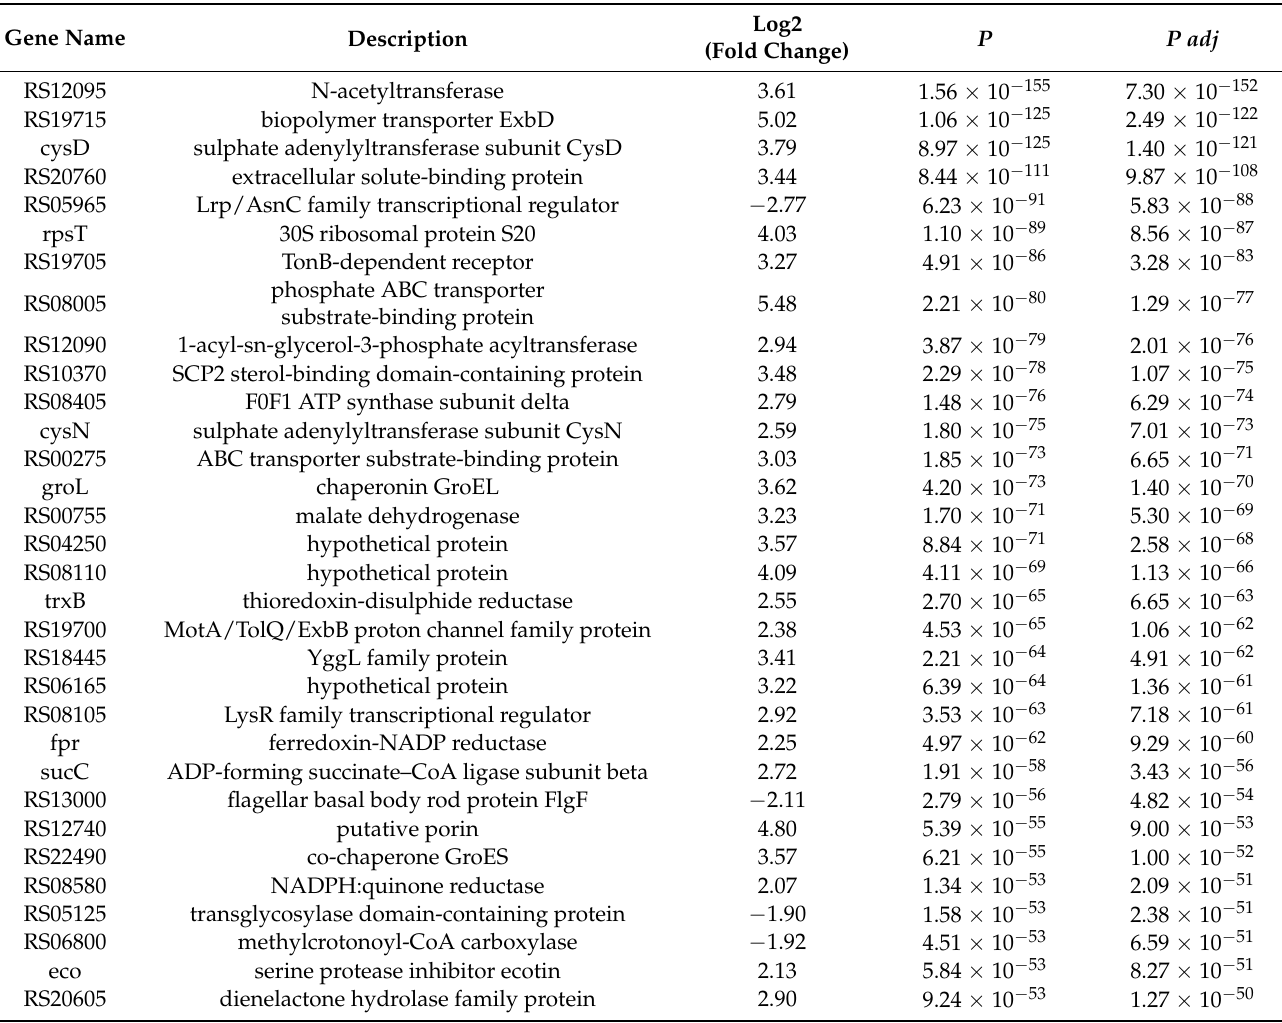
Table 1. The DEGs of P. fragi ’s responses to linalool (top